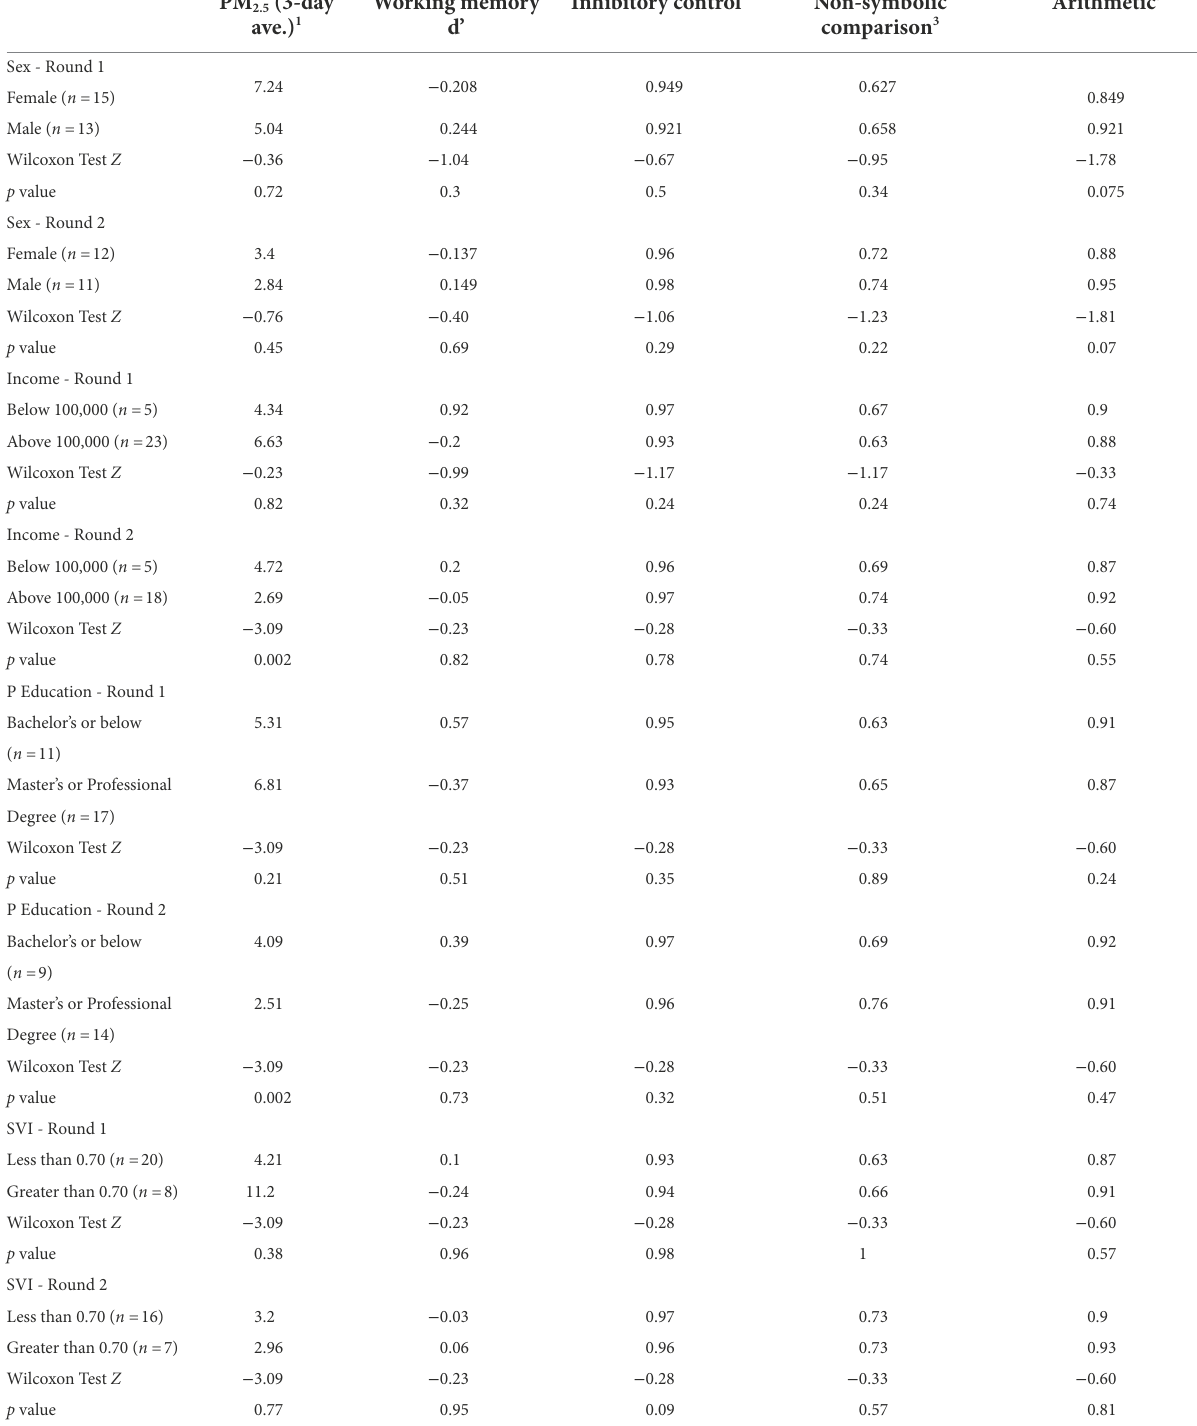
TABLE 5 Differences between demographic categories on all